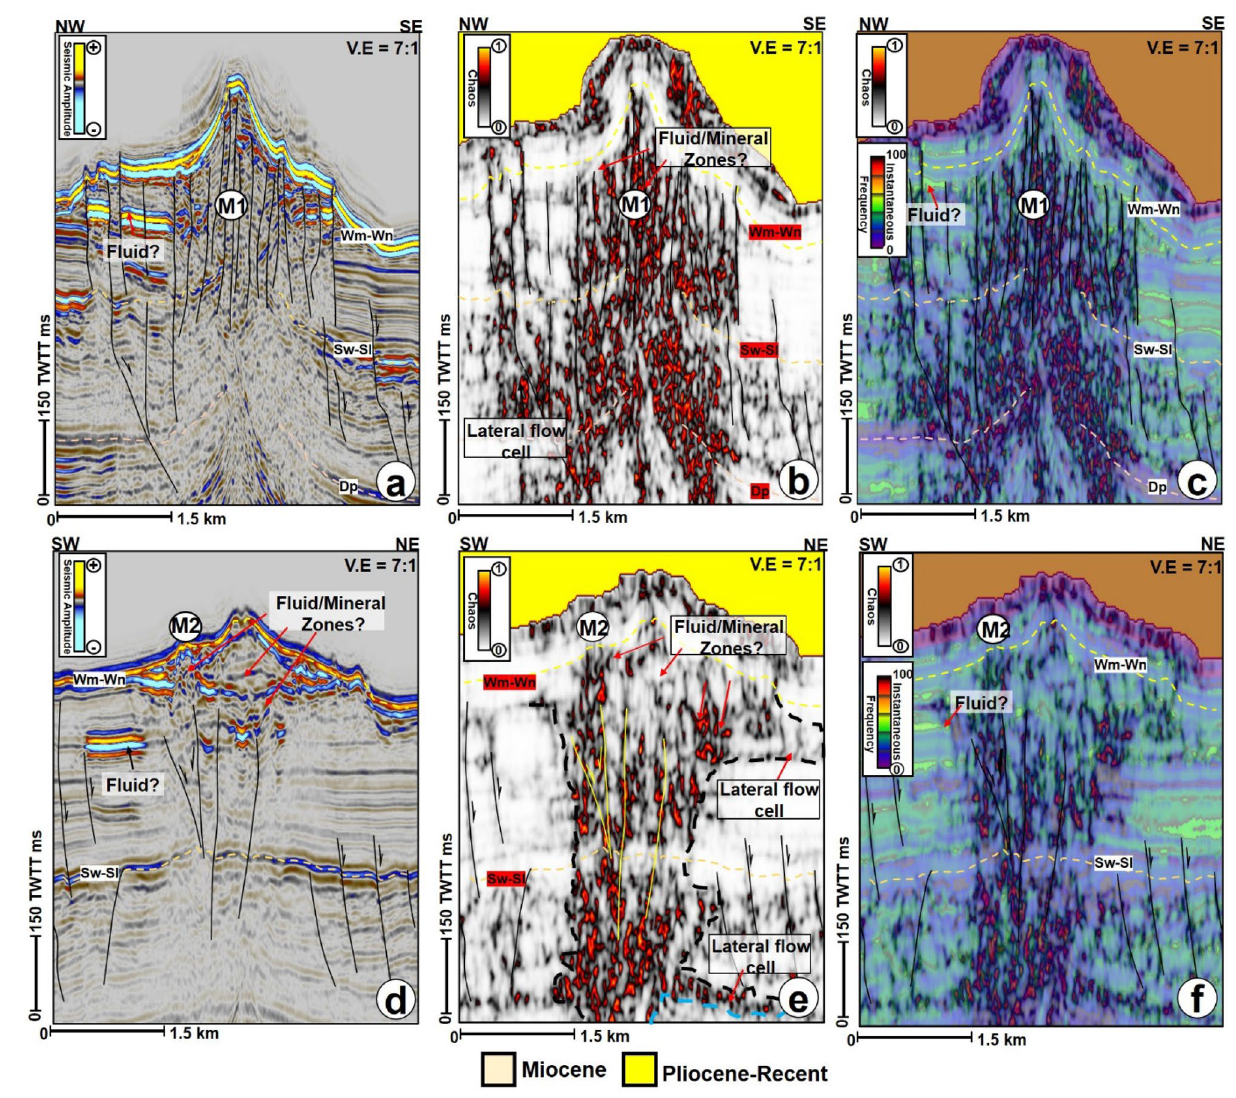
Figure 8. Internal architectures of seafloor mounds ( a )–( c ) M1 and ( d )–( f ) M2 as revealed by the amplitude, chaos and instantaneous + chaos profiles. M1 and M2 have cone-shaped and plateau-like zeniths, respectively and are intersected by different faults within the Pliocene-Recent strata. Note: Profiles in ( c ) and ( f ) are chaos profiles overlain by instantaneous frequency profiles. TWTT: Two-way travel time in milliseconds. The uninterpreted seismic sections are provided in the supplementary document